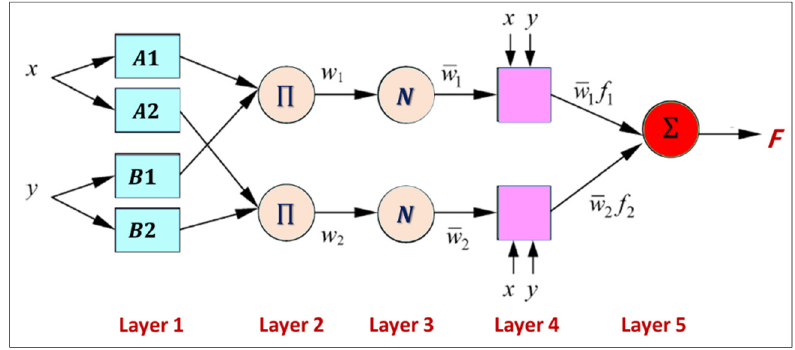
Figure 4. ANFIS system with a two-rule Sugeno system.